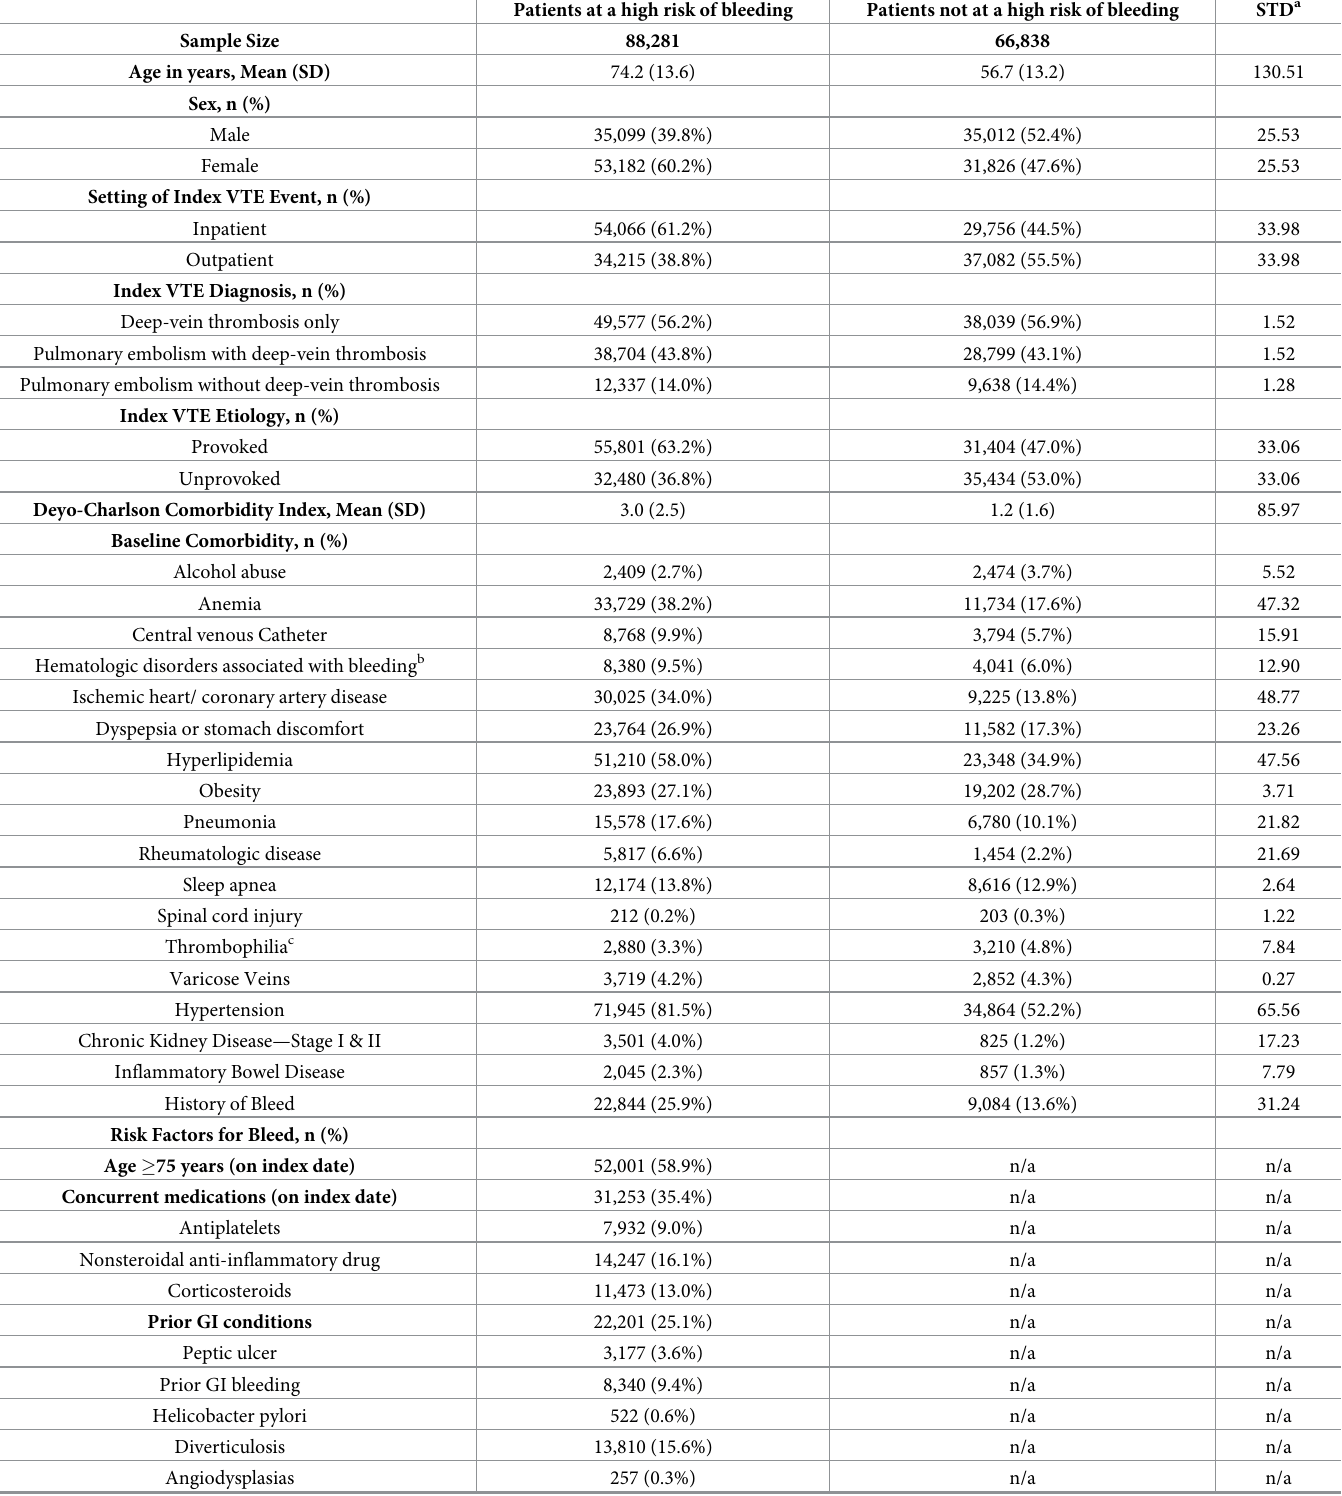
Table 1. Descriptive baseline characteristics among VTE patients at and not at a high risk of